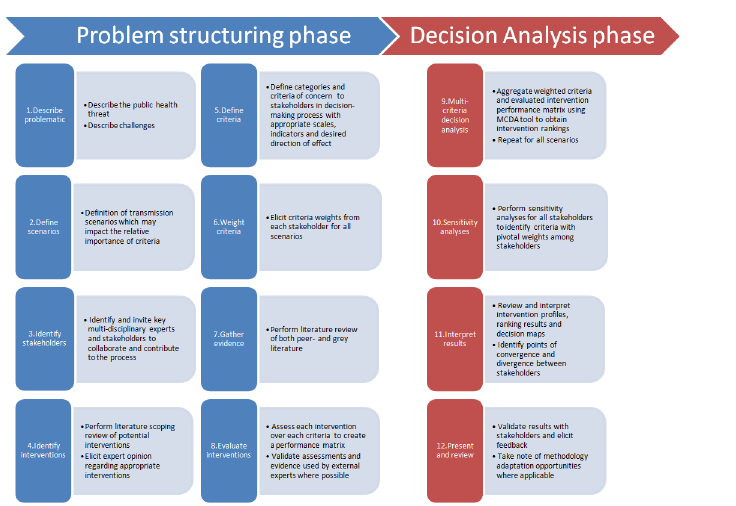
Fig 1. Schematic representation of the MCDA approach (adapted from